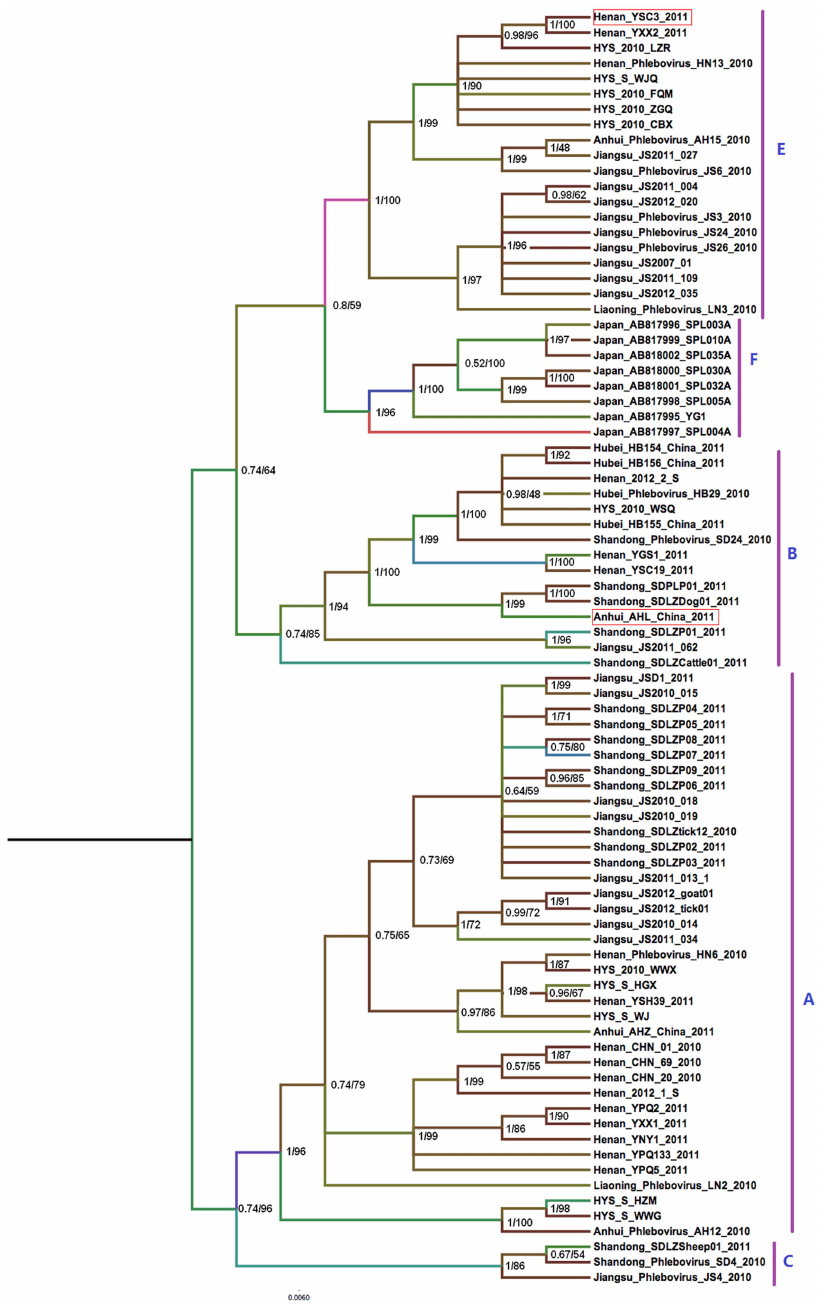
Figure 3. Bayesian coalescent analysis of FTLSV based on the S segment. Maximum clade credibility and Maximum likelihood tree is shown with posterior probability values and bootstrap value depicted at the nodes. Phylogenetic analysis was carried out using Mrbayes 3.2.1 and Mega software 5, respectively. Designations of the different FTLSV phylogroups (A,B,C,E,F clade) are as indicated, based on previously defined assignments. These sequences are described in more detail in Table 1. The sequences from Japan were included in this